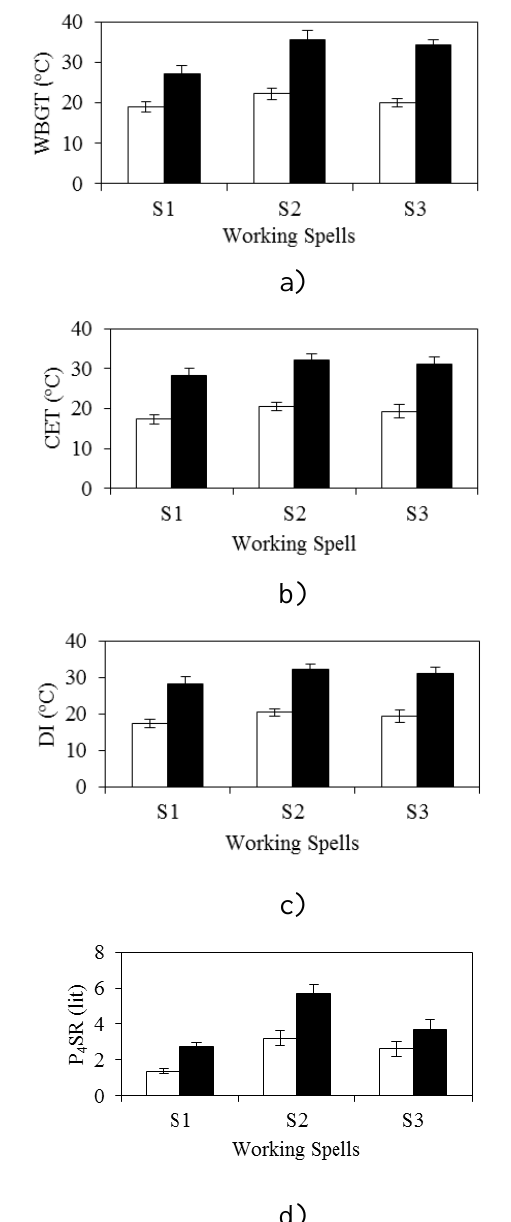
Figure 1. Thermal environmental status